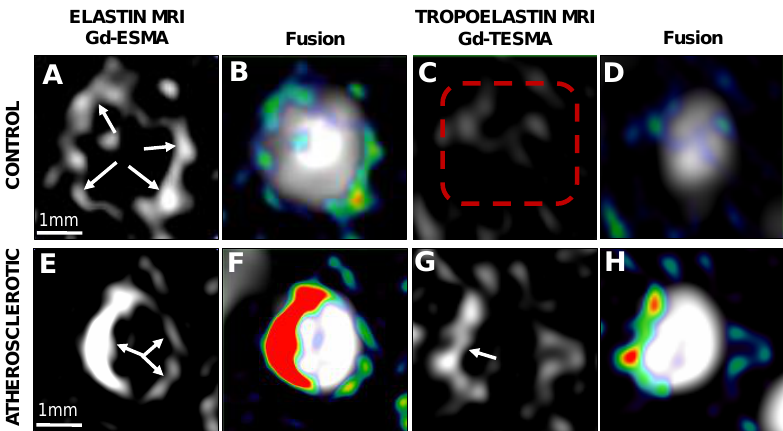
Figure 4. In vivo MRI comparison of vessel wall enhancement using the elastin ( Gd-ESMA ) and tropoelastin ( Gd-TESMA ) in mice (both 0.2 mmol Gd 3+ /kg): fused maximum intensity projection reconstructed MR angiography and delayed-enhanced-MRI after administration of Gd-TESMA in the brachiocephalic artery (BCA) of an atherosclerotic ApoE − / − mouse. ( A – D ): MRI of the BCA acquired from a control animal, scanned 24 h apart. ( E – H ): MRI of the BCA acquired from a diseased animal. This figure is adapted with permission of American Heart Association from ref.